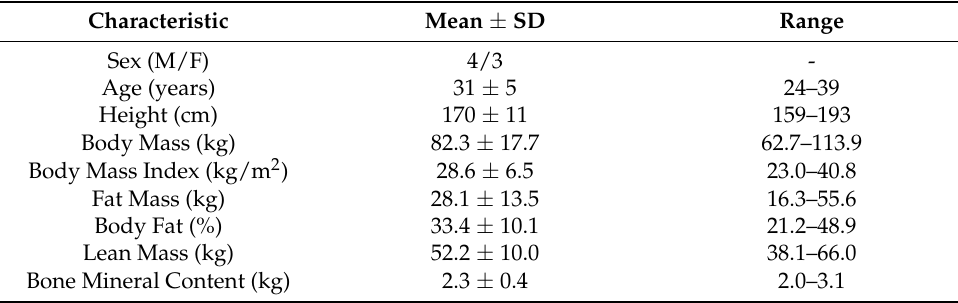
Figure 1. Consolidated Standards of Reporting Trials (CONSORT) flow diagram. Table 1. Selected physiological characteristics of study participants.